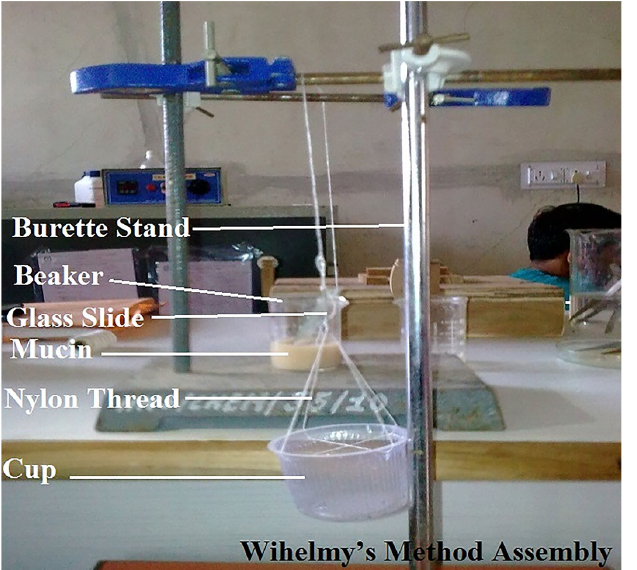
FIGURE 1 - Wihelmy’s Method to measure mucoadhesive strength.